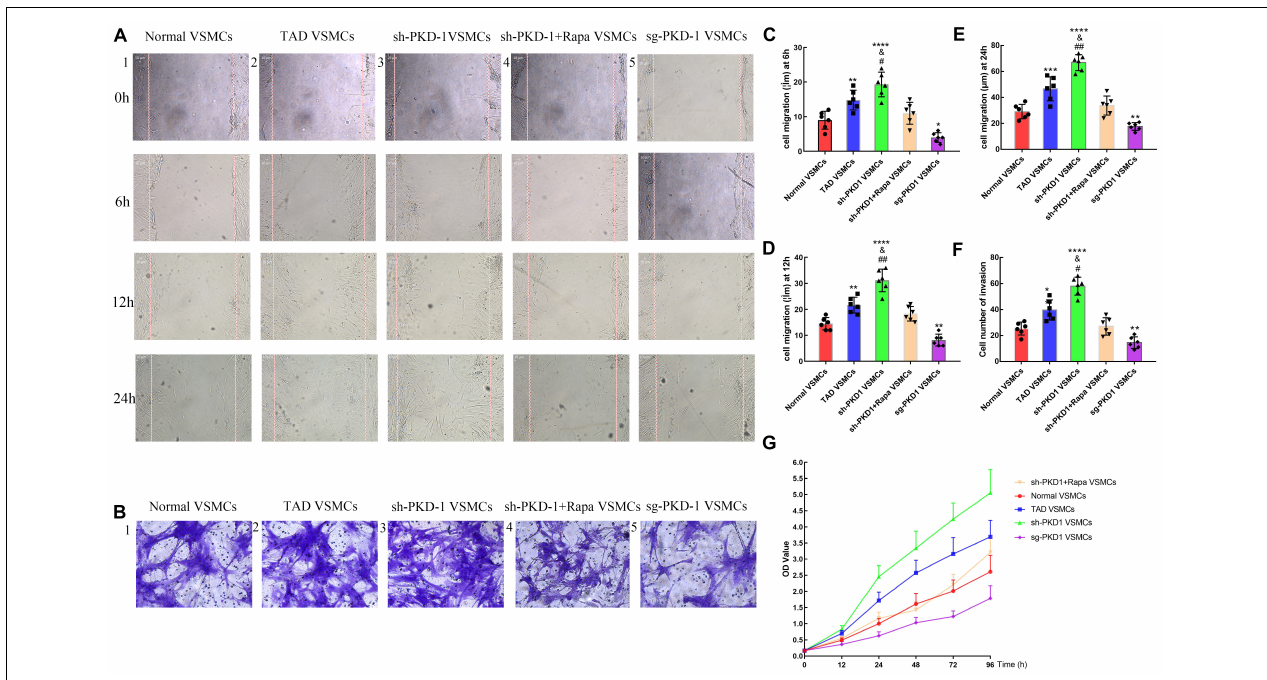
FIGURE 7 | Cell migration and proliferation among groups ( n = 6 for each group). (A1–5) Wound healing assay and (B1–5) transwell assay showed that cell migration was increased at (C ) 6 h, (D) 12 h, and (E,F) 24 h in TAD VSMCs ( p = 0.0051, p = 0.0016, p = 0.0004, p = 0.0021) and sh-PKD-1 VSMCs ( p < 0.0001, p < 0.0001, p < 0.0001, p < 0.0001), but inhibited in (C–F) sg-PKD-1 group ( p = 0.0174, p = 0.0051, p = 0.0191, p = 0.0021) compared with normal VSMCs. Cell migration was enhanced at these points (C–F) in sh-PKD-1 VSMCs ( p = 0.0364, p = 0.0013, p = 0.0012, p = 0.0216) compared with TAD VSMCs. After treatment of rapamycin to sh-PKD-1 VSMCs, cell migration showed no significance compared with normal VSMCs. (G) Proliferation of VSMCs was enhanced at 12, 24, 48, 72, and 96 h in TAD VSMCs and sh-PKD-1 VSMCs, but mitigated in sg-PKD-1 group compared with normal VSMCs. Cell proliferation was promoted at these points in sh-PKD-1 VSMCs compared with TAD VSMCs. * p < 0.05, ** p < 0.01, *** p < 0.001, **** p < 0.0001 (compared with normal VSMCs); # p < 0.05, ## p < 0.01 (compared with TAD